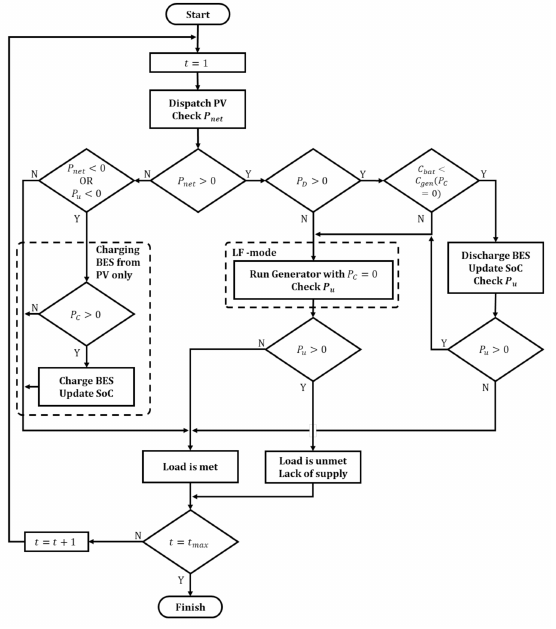
Figure 1. Load Following (LF) control strategy. This strategy does not allow the generator to charge the battery, and BES is discharged every time the SOC is greater than the SOC minimum.